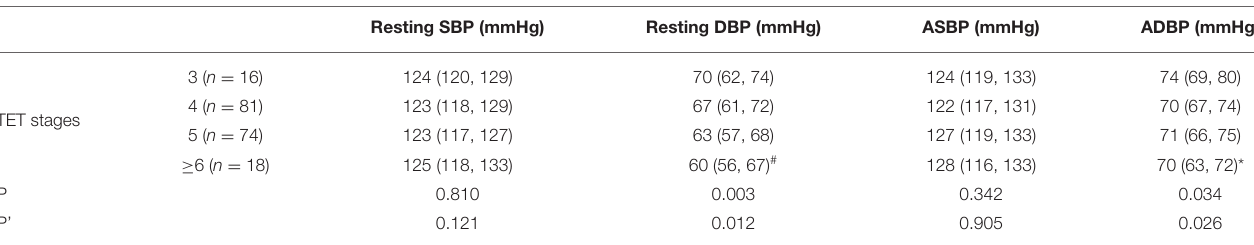
TABLE 3 | Comparison of blood pressure value between different TET